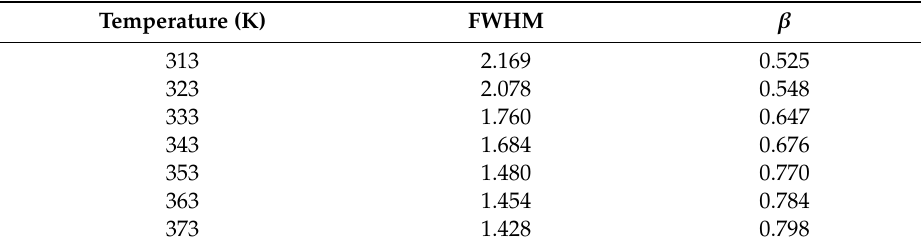
Table 3. The values of FWHM and stretching exponent for M (cid:48)(cid:48) versus